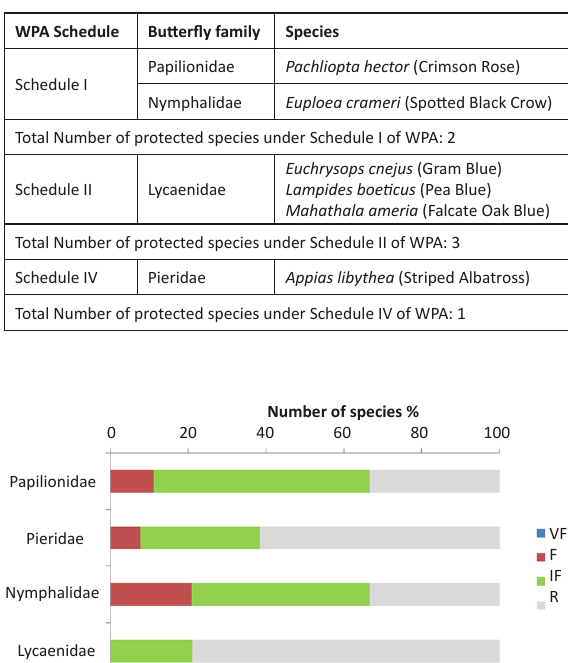
Table 2. Overview of the taxonomic diversity of butterflies of Sundarbans.